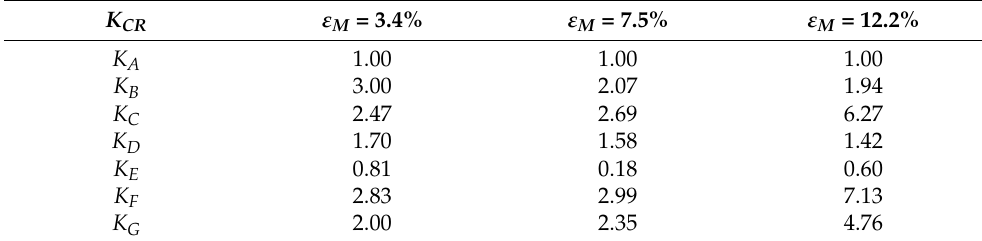
Table 3. K CR of marked points at different tensile stages. K CR ε M =